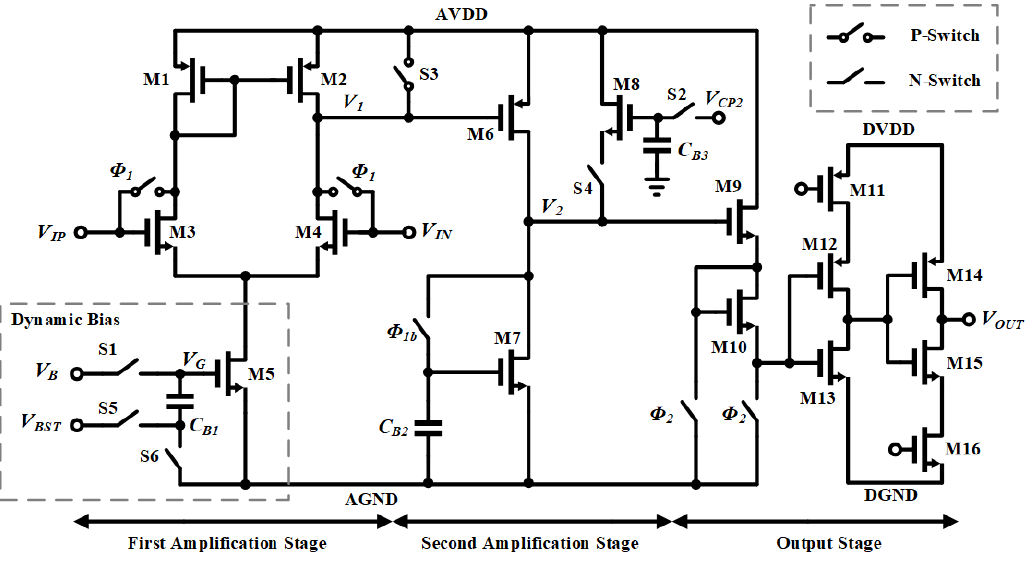
Figure 9. Schematic diagram of the proposed